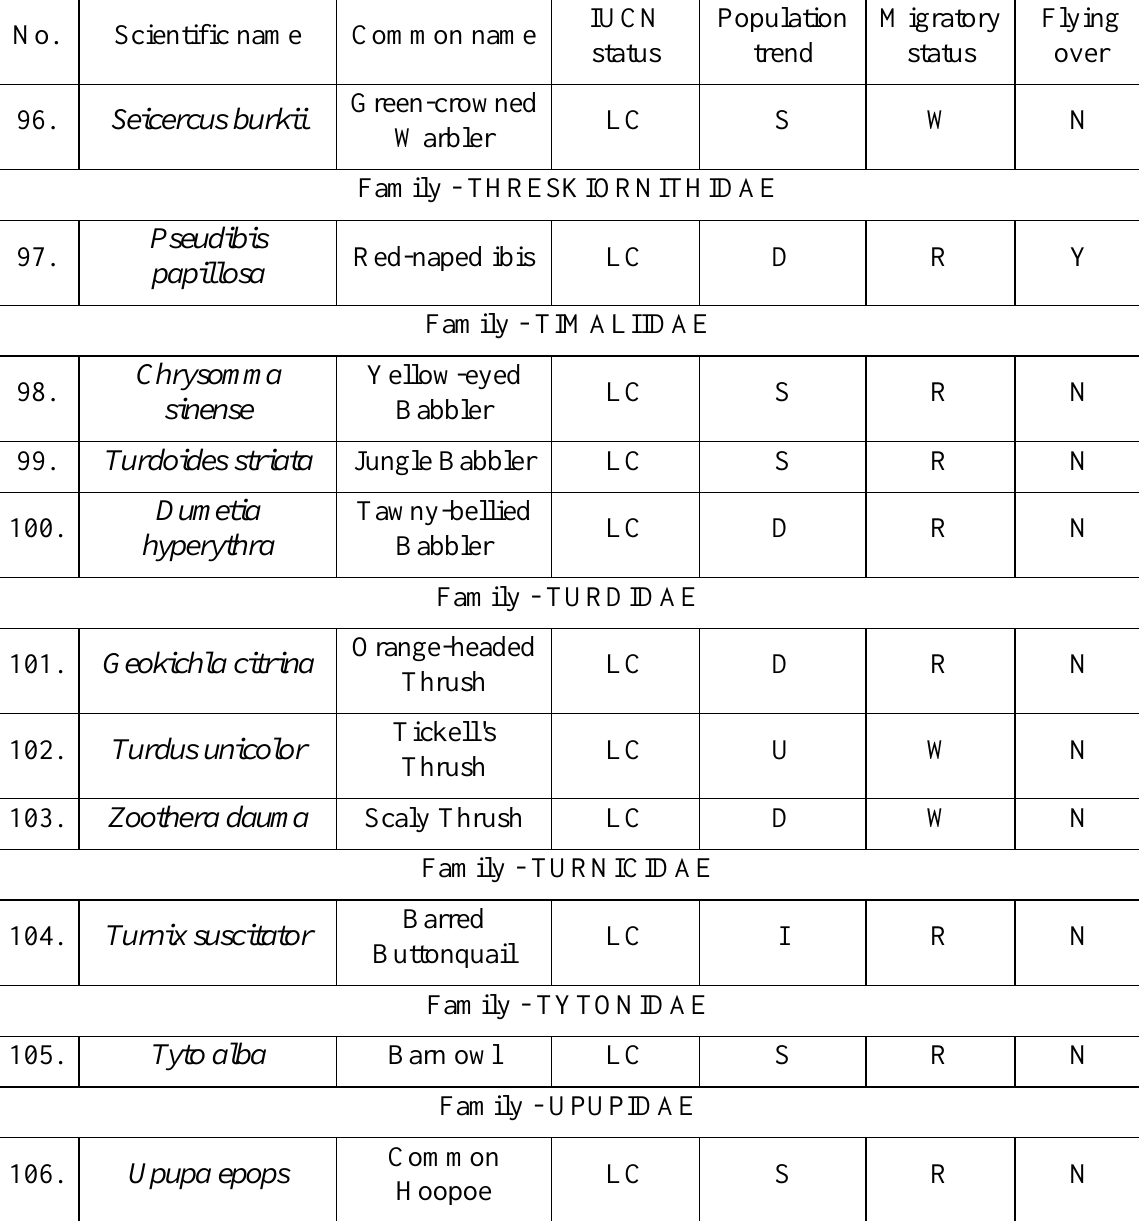
Table 1. List of bird species recorded in Durgapur Government College Campus